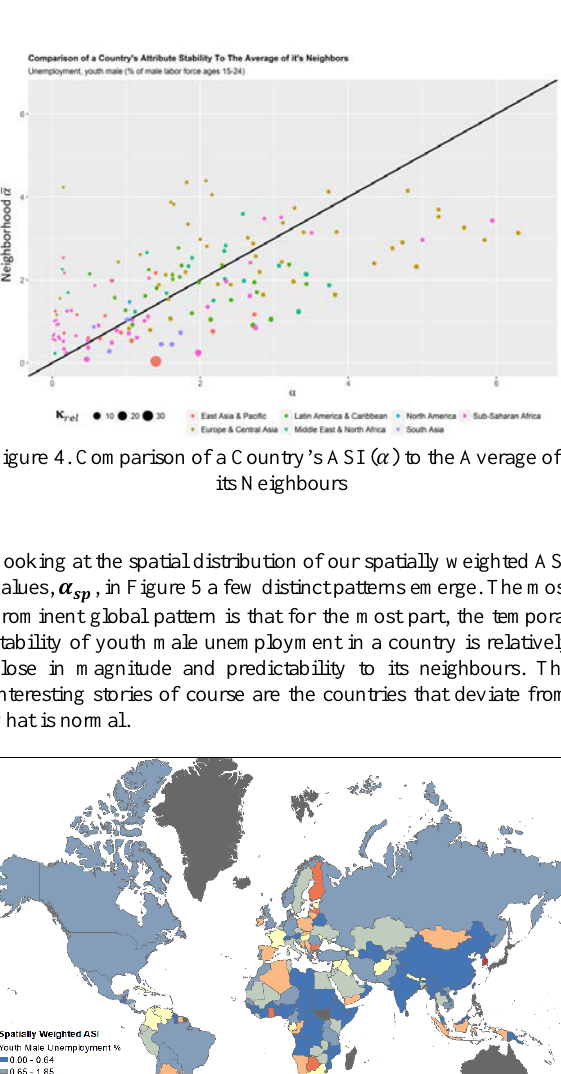
𝜶𝜶 𝒔𝒔𝒔𝒔 ) The country with the lowest, , the country that is the most 𝛼𝛼 𝑠𝑠𝑠𝑠